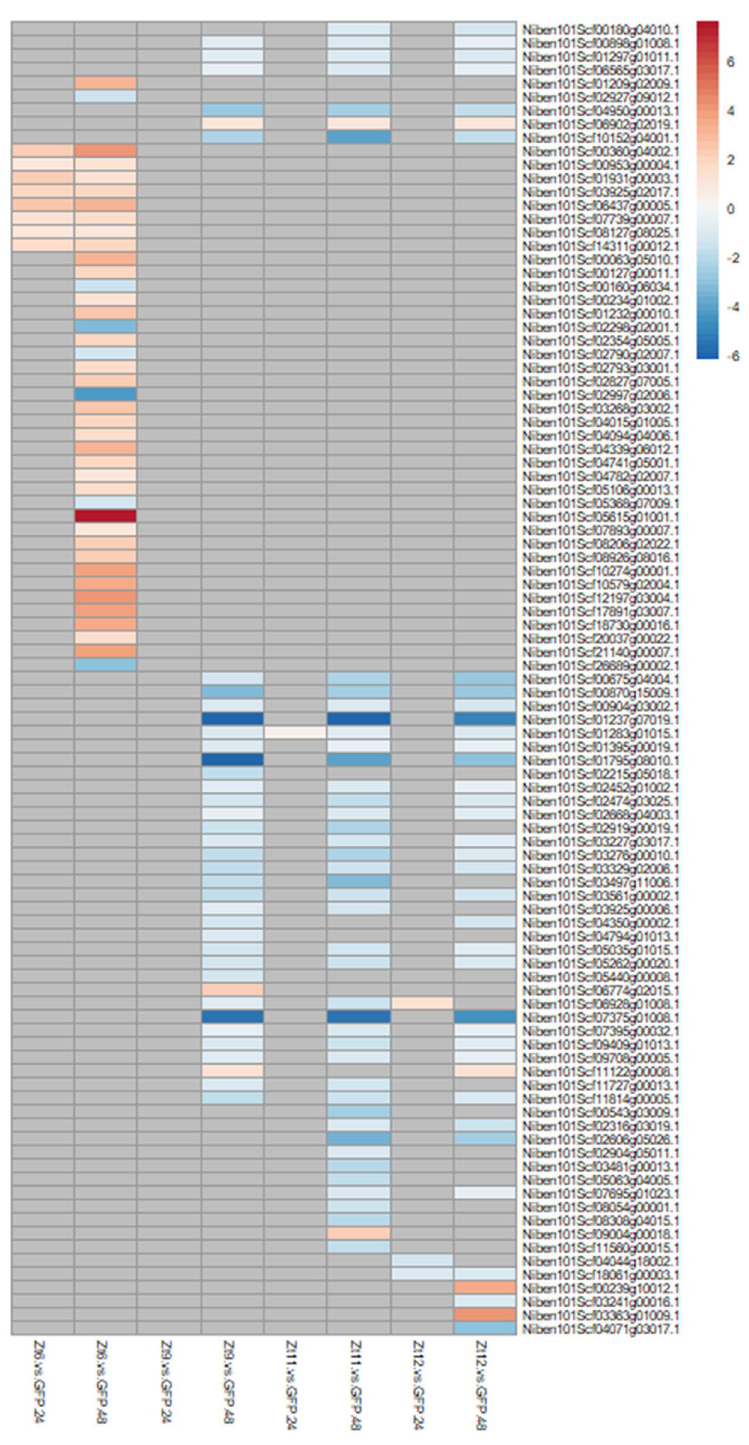
Figure 5. Expression profile of RLPKs genes with marked difference in expression change between Zt6 and Zt9, Zt11, and